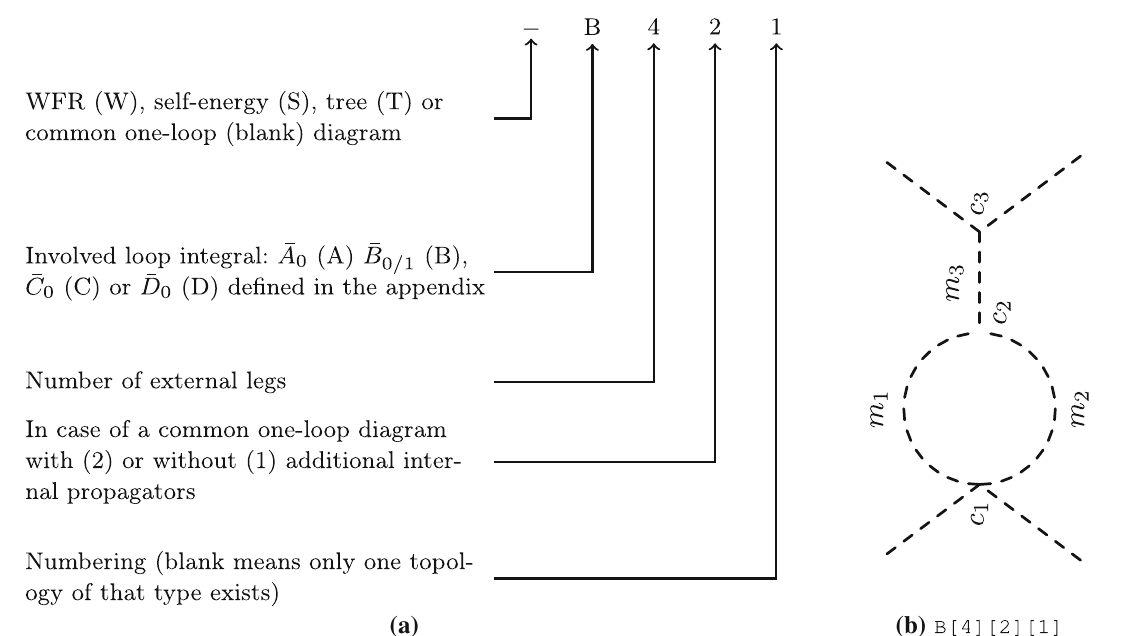
Fig. 13 Notation on topologies appearing in generic one-loop diagrams. The example expression explained in a corresponds for instance to the diagram shown in